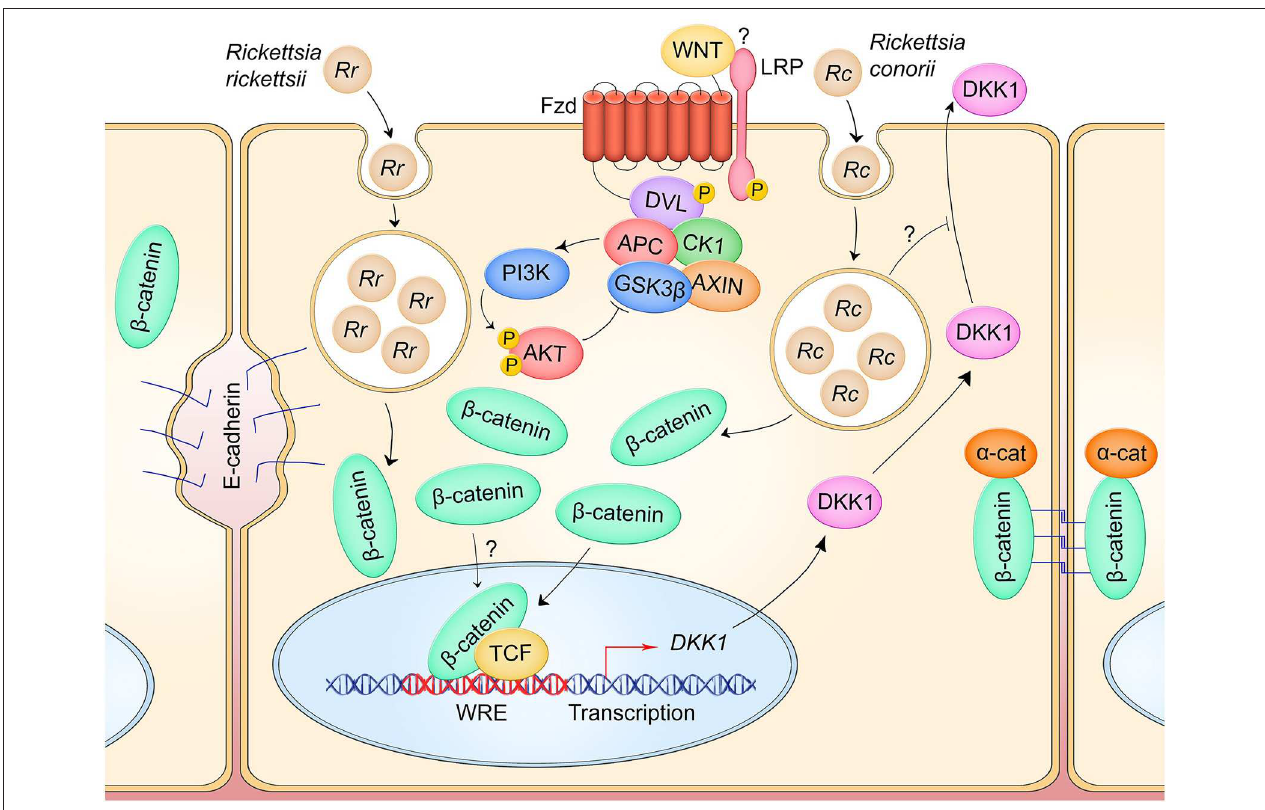
FIGURE 4 | Canonical Wnt signaling manipulation during Rickettsia spp. infection of endothelium. R. rickettsii (Rr) infection of endothelial cells induces breakdown of adherens junctions and accumulation of cytoplasmic β -catenin which may drive pathway activity (left). R. conorii (Rc) infection leads to a suppression of secreted Wnt antagonist DKK1, which may facilitate activation of Wnt signaling to induce an anti-inflammatory environment during infection. IL-6 and IL-8 secretion are suppressed during infection in a DKK1-dependent